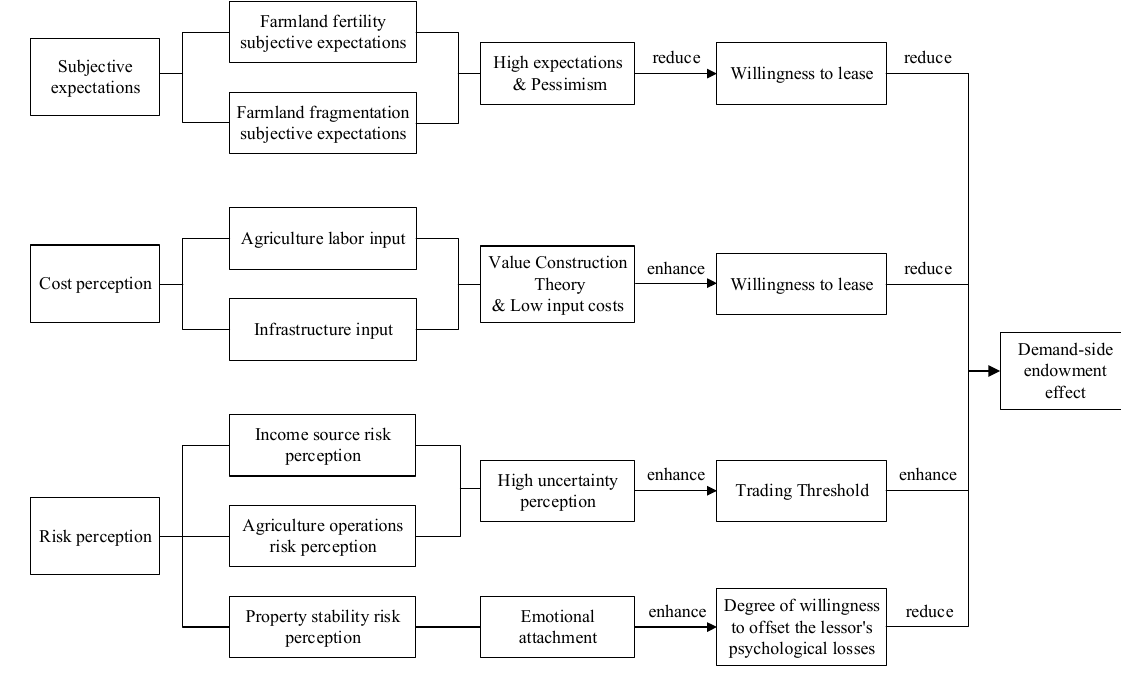
Figure 2. Influencing factors of demand-side endowment effect.